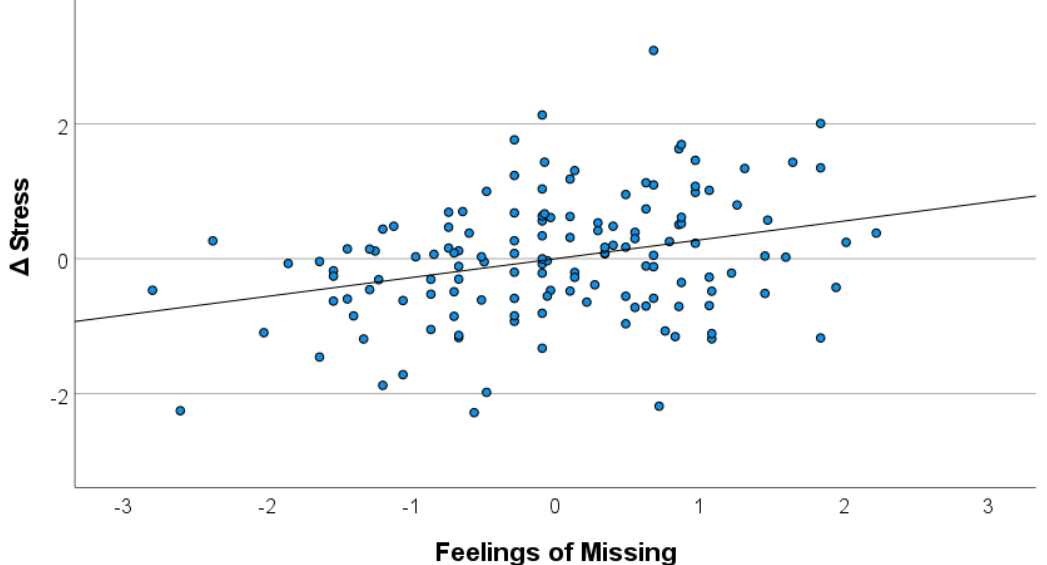
∆ stress) and ratings of “feelings of